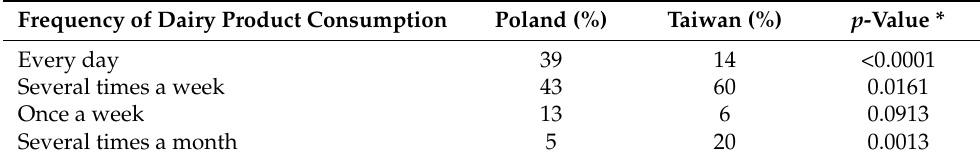
Table 2. Dairy consumption